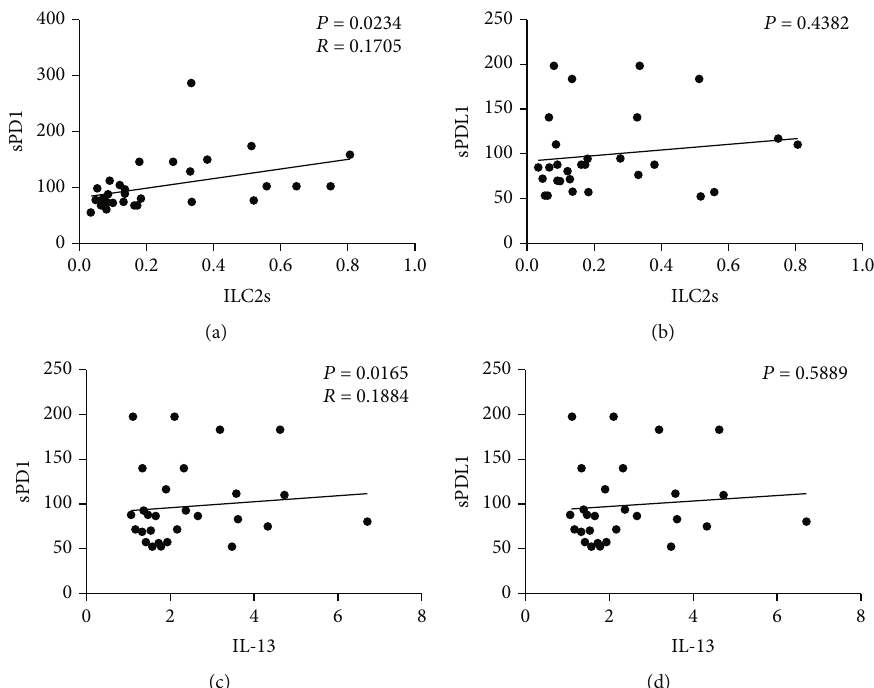
Figure 6: Correlation analysis between sPD1 and sPDL1 with ILC2s and IL-13. The correlation of ILC2s% and sPD1 (a) and sPDL1 (b). The correlation of IL-13 and sPD1 (c) and sPDL1 (d). Data shown were represented as mean ± SD (all samples were measured in triplicate). Ns: not signi fi